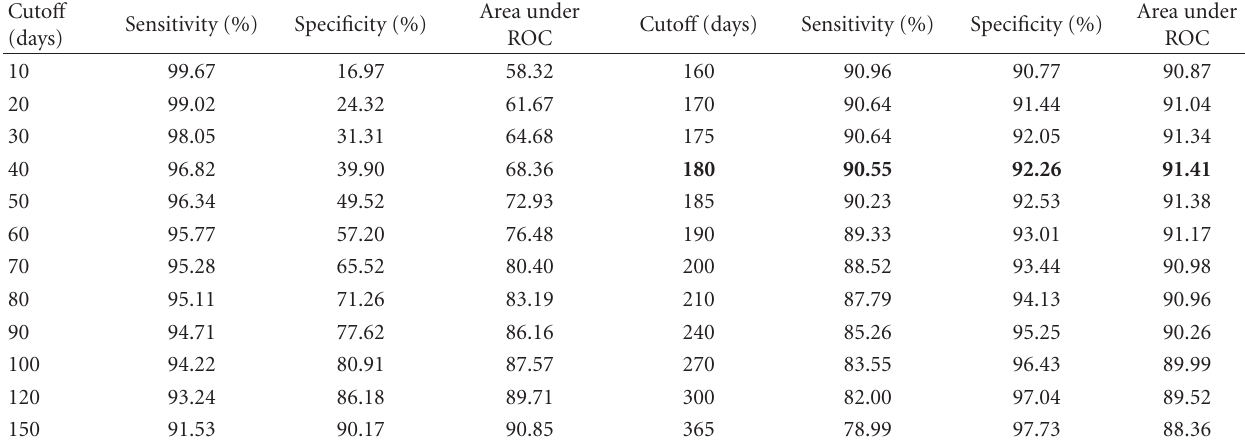
Table 1: Receiver operating characteristic (ROC) analysis for the best-performing definition for loss to followup. Cuto